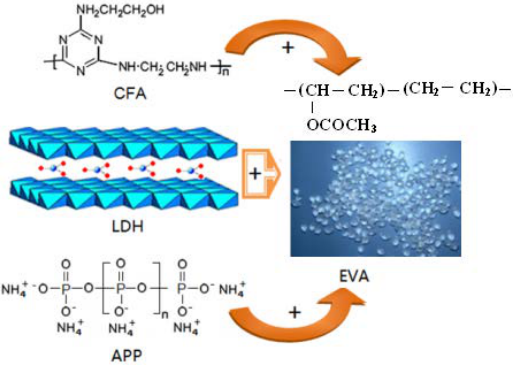
Figure 1. Schematic representation of CFA (charing-foaming agent)/APP (ammonium polyphosphate)/LDHs (layered double hydroxides) and EVA (ethylene vinyl acetate). LDHs (layered double hydroxides) and EVA (ethylene vinyl